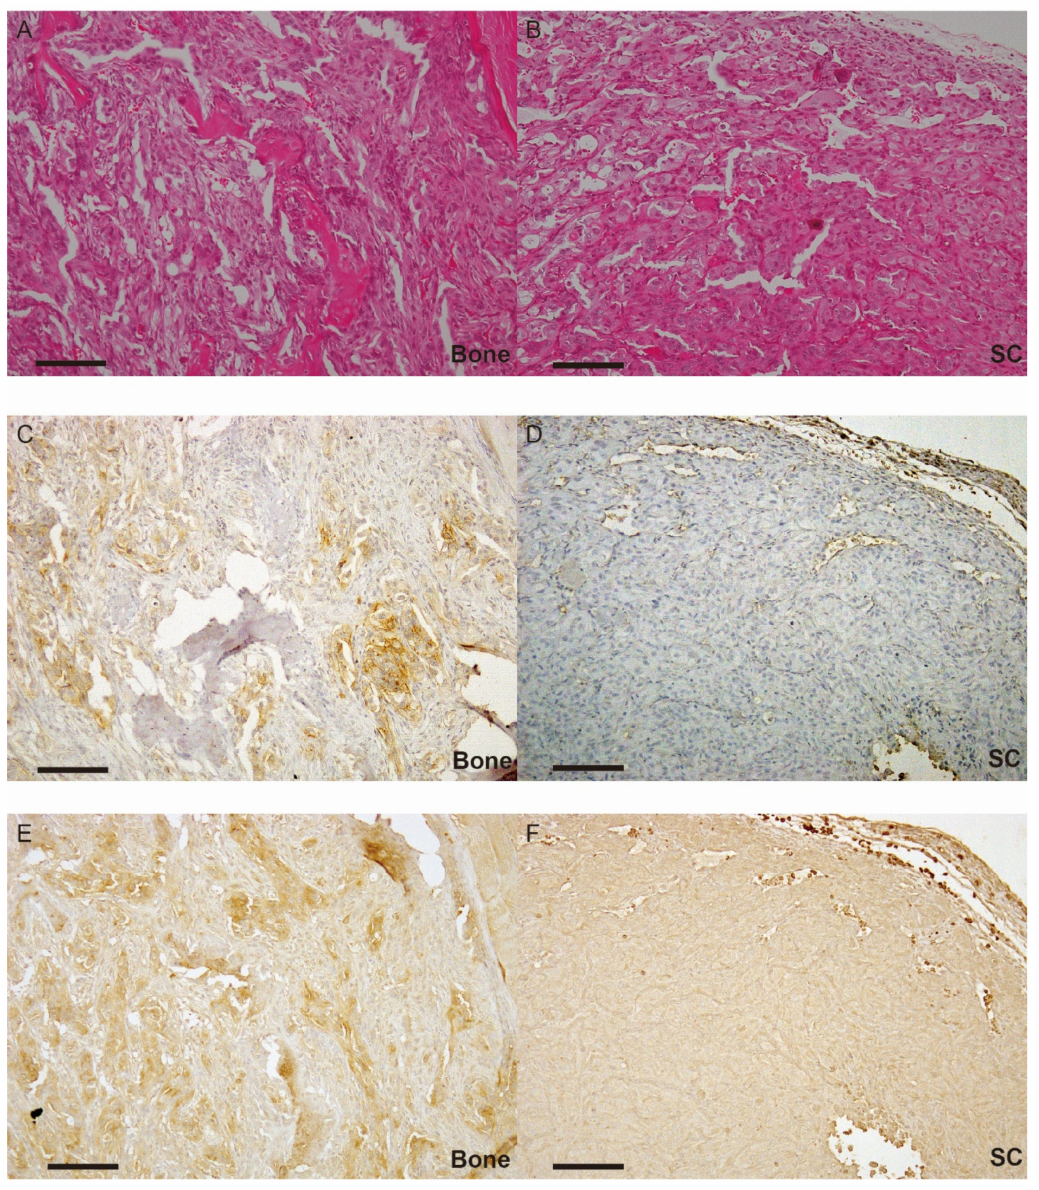
Figure 3. Pathological and immunohisitochemical appearance of bone metastasis and subcutaneous implantation of 786-O-Luc2 cells using serial tissue sections. ( A ) Bone metastasis (bone), stained with hematoxylin and eosin (H&E); ( B ) subcutaneous implantation (SC), stained with H&E; ( C ) bone, phosphorylation of MET (p-MET) immunostaining; ( D ) SC, p-MET immunostaining; ( E ) bone, total-MET (t-MET) immunostaining; ( F ) SC, t-MET immunostaining. Scale bars = 100 µ